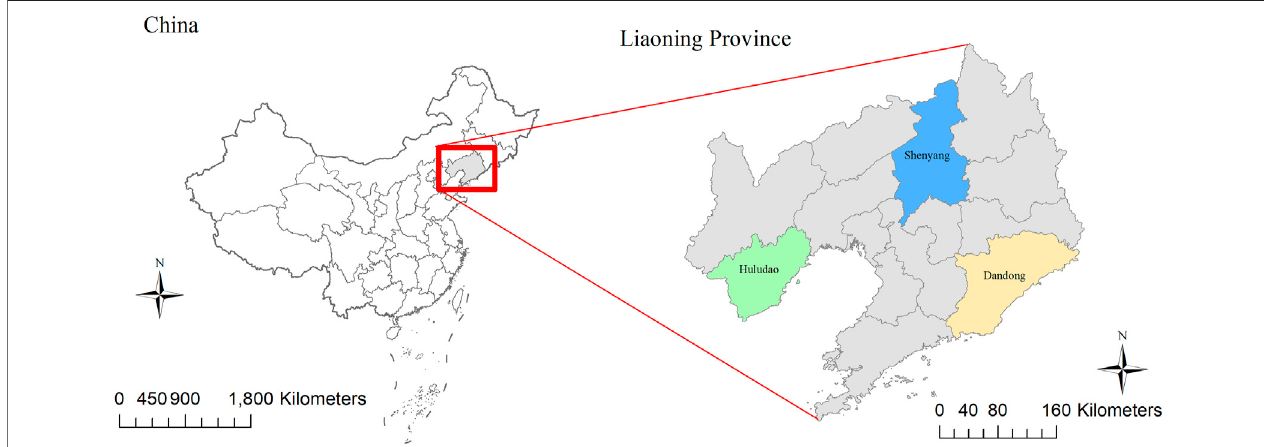
FIGURE 1 | Geographical distribution of study areas in China. The map was created by ArcGIS 10.3 (Environmental Systems Research Institute; Redlands, CA, USA). The base map was acquired from data center for geographic sciences and natural sources research, CAS (http://www.resdc.cn/).